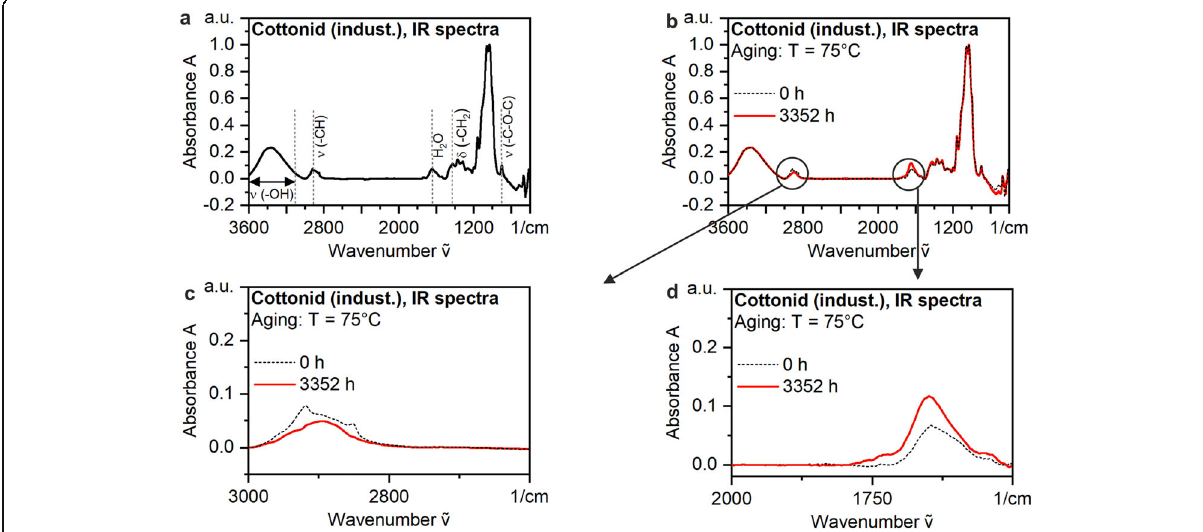
Fig. 3 Infrared (IR) spectra of industrial Cottonid material (Ernst Krueger): a In initial condition with peak definition of raw material cellulose, and b Comparative evaluation of initial condition and after thermal aging at ~ 75 °C for t aging = 3352 h; Peak evolution due to thermal aging: c Close-up at ṽ = 2.900 cm − 1 , and d Close-up at ṽ ~ 1.750 cm − 1